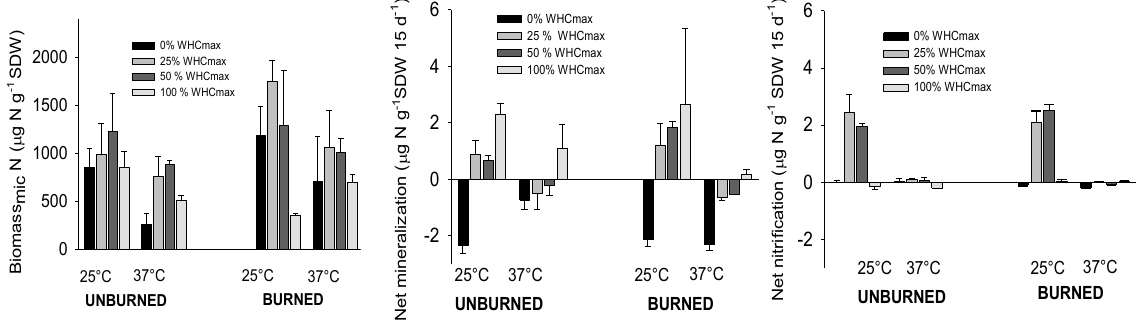
Fig. 8. Microbial biomass N (µgNg − 1 soil dry weight) and rates of net N mineralization (µgNg − 1 soil dry weight) and net nitrification (µgNg − 1 soil dry weight) measured after 2 weeks of incubation in soil from burned and unburned plots incubated at 0, 25, 50 and 100% of WHC max and at two temperatures (25 ◦ C or 37 ◦